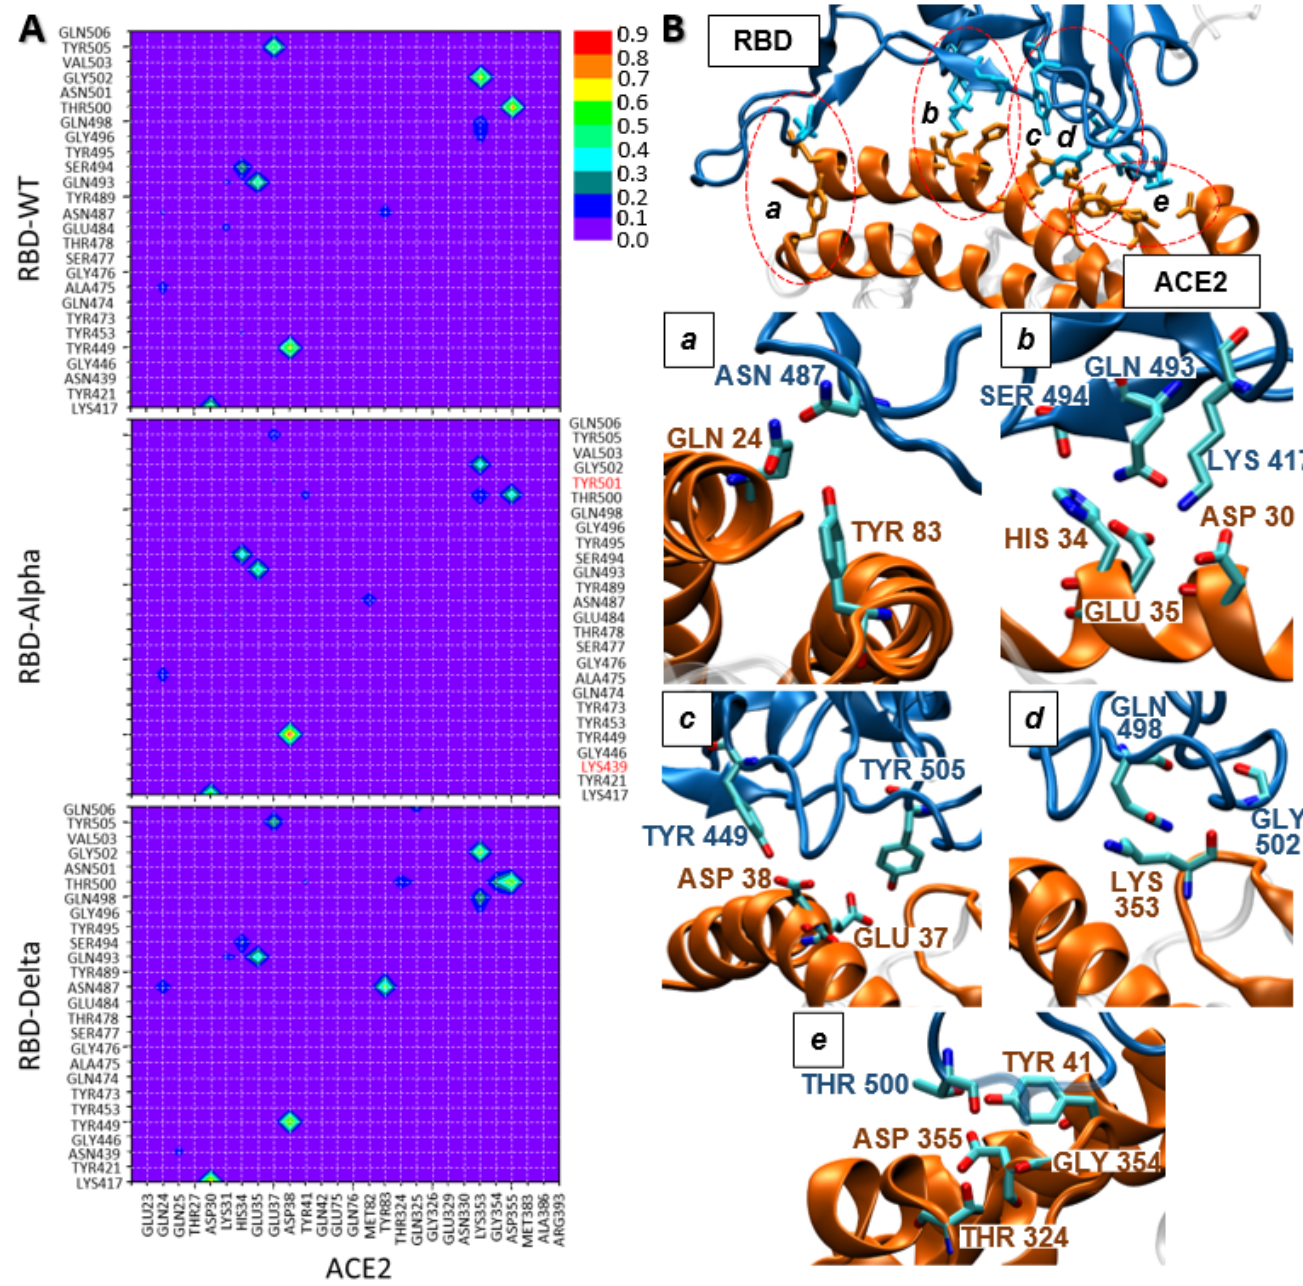
Figure 2. ( A ) 2D maps of hydrophilic interactions between WT-, Alpha-, and Delta-RBD and ACE2 residues. ( B ) Representative snapshots showing the amino acids involved in the main hydrophilic interactions. Snapshots are extracted from the structure ACE2/WT-RBD cluster 0. Sub-figures ( a – e ) correspond to different fractions of the ACE2/RBD interaction region.